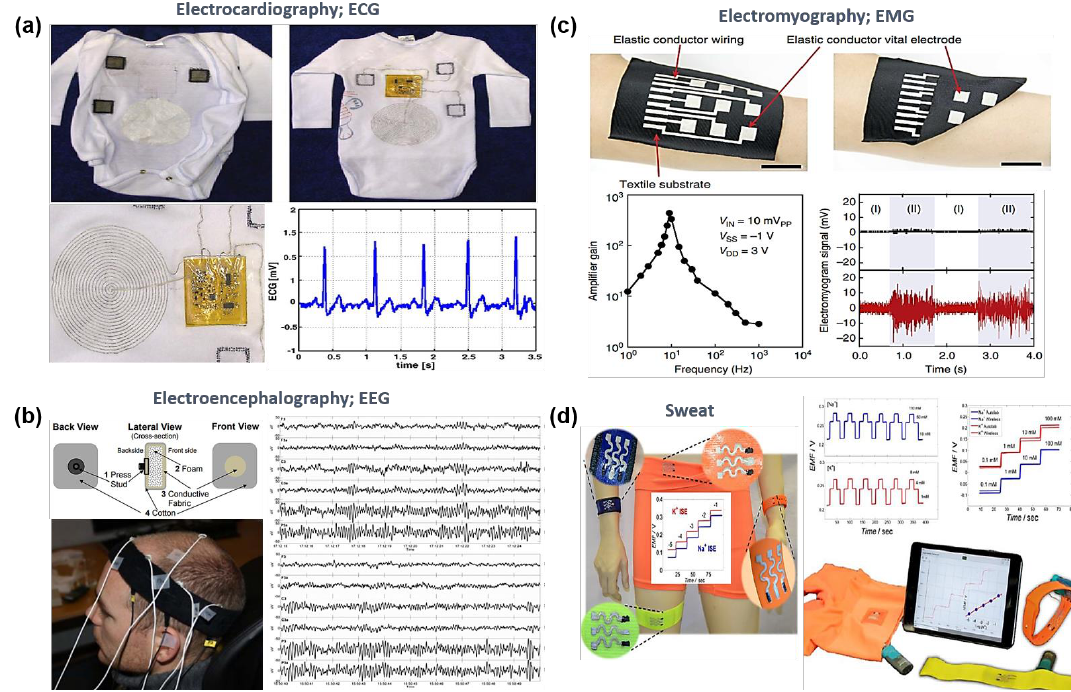
Figure 8. Textile-based wearable sensors for biophysiological signals. ( a ) Textile-based baby suit prototype with the embroidered coil for monitoring a continuous ECG signal (reproduced with permission [148] copyright 2006 Elsevier). ( b ) The hair bandage-type EEG signal sensor using soft and tender textile-based electrodes and EEG signals (reproduced with permission [150] copyright 2018, MDPI AG). ( c ) Measurement of arm EMG signals with an elastic conductor electronic textile and EMG signals obtained through the elastic conductor attached to a forearm while opening (I) and closing a hand (II) (reproduced with permission [152] copyright 2015, Springer Nature). ( d ) A textile-based wearable multi-ion sweat sensor array using composites with PU-based ion-selective membranes and CNT inks for detecting the change in concentration of sodium and potassium (reproduced with permission [155] copyright 2017, Wiley-VCH).